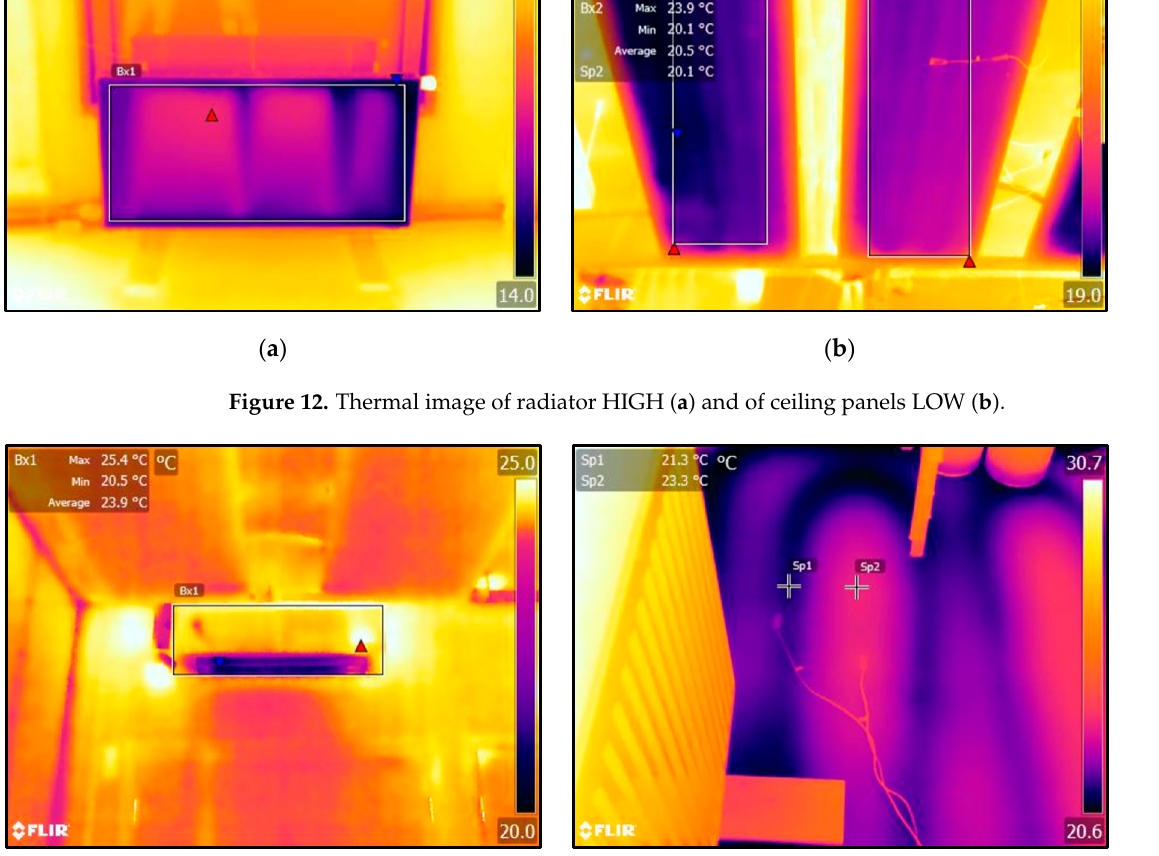
face temperature difference between the two panels.